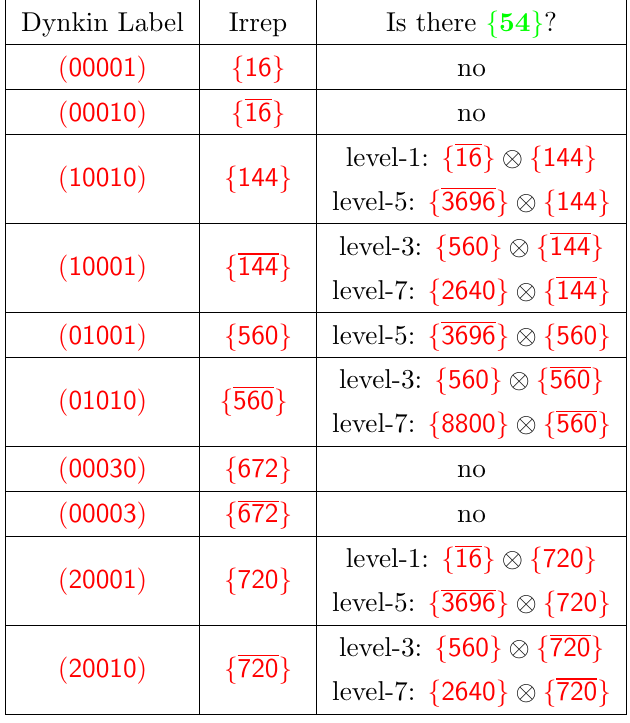
Table 8 . Summary of tensoring spinorial irreps onto the scalar